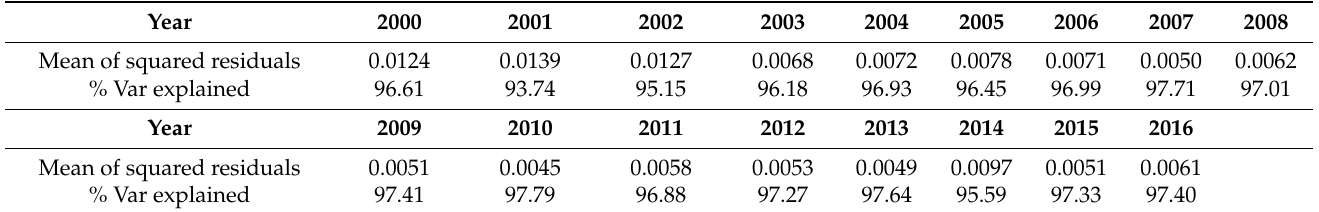
Table 3. Performance evaluation of random forest regression models from 2000 to